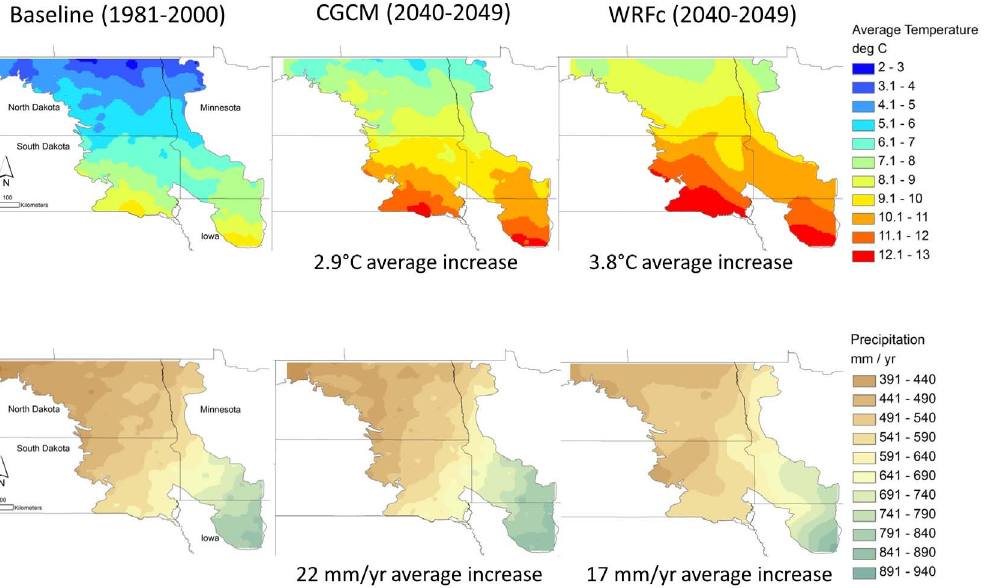
Figure 3. Temperature and precipitation for baseline and two future climate projections for the prairie potholes of North Dakota, South Dakota, Minnesota, and Iowa.